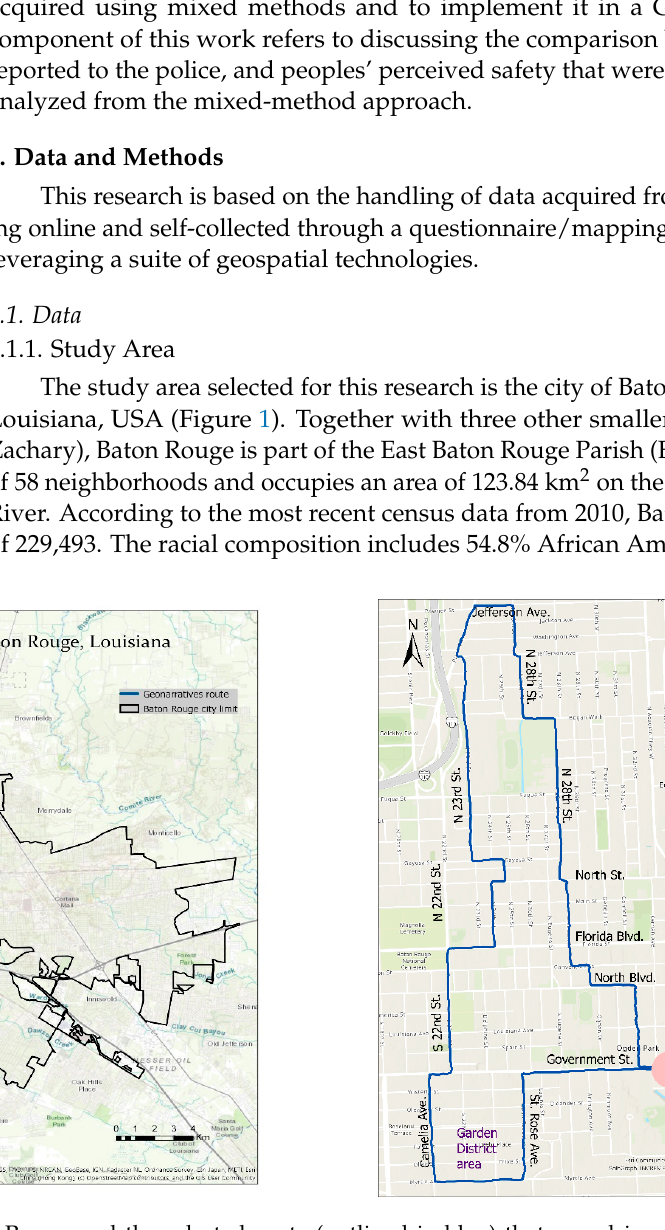
Figure 1. The city of Baton Rouge and the selected route (outlined in blue) that was driven by researchers and test participants for fine-scale geospatial data collection (left side) and the detailed route (right side).